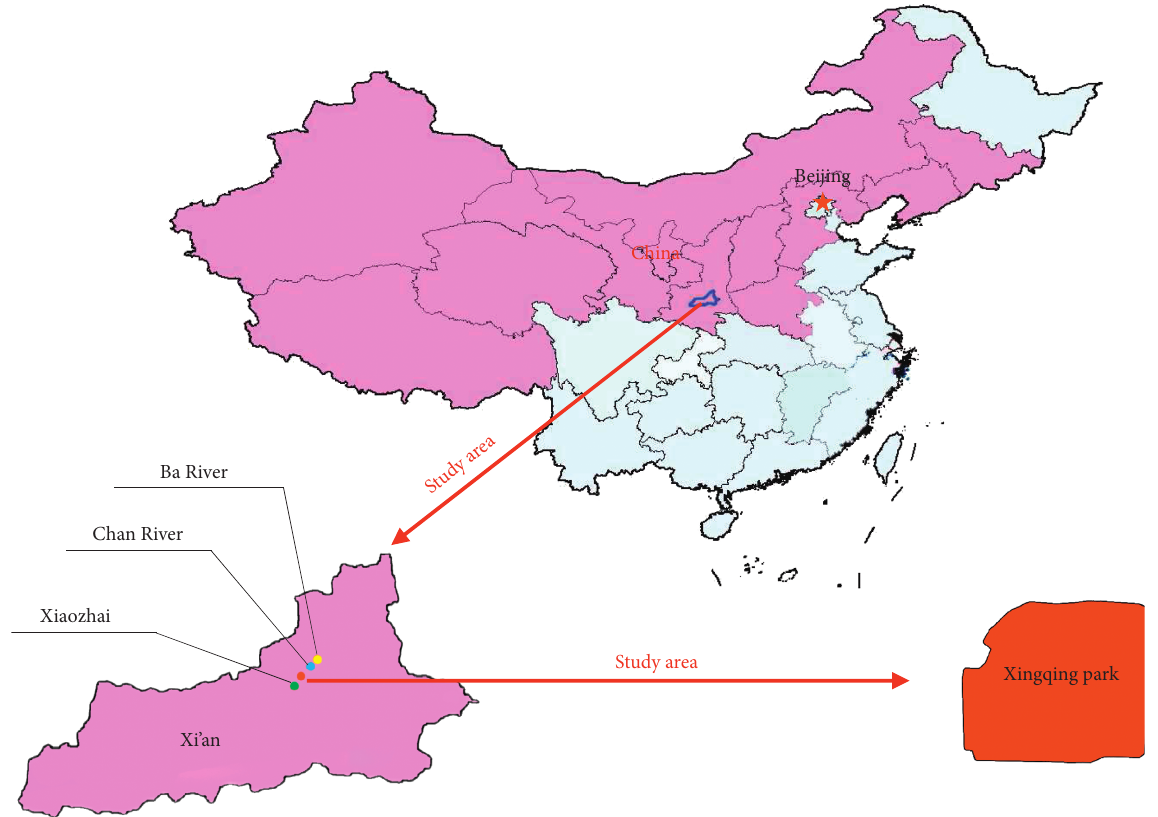
Figure 1: Main distribution of saturated soft loess in Xi’an,